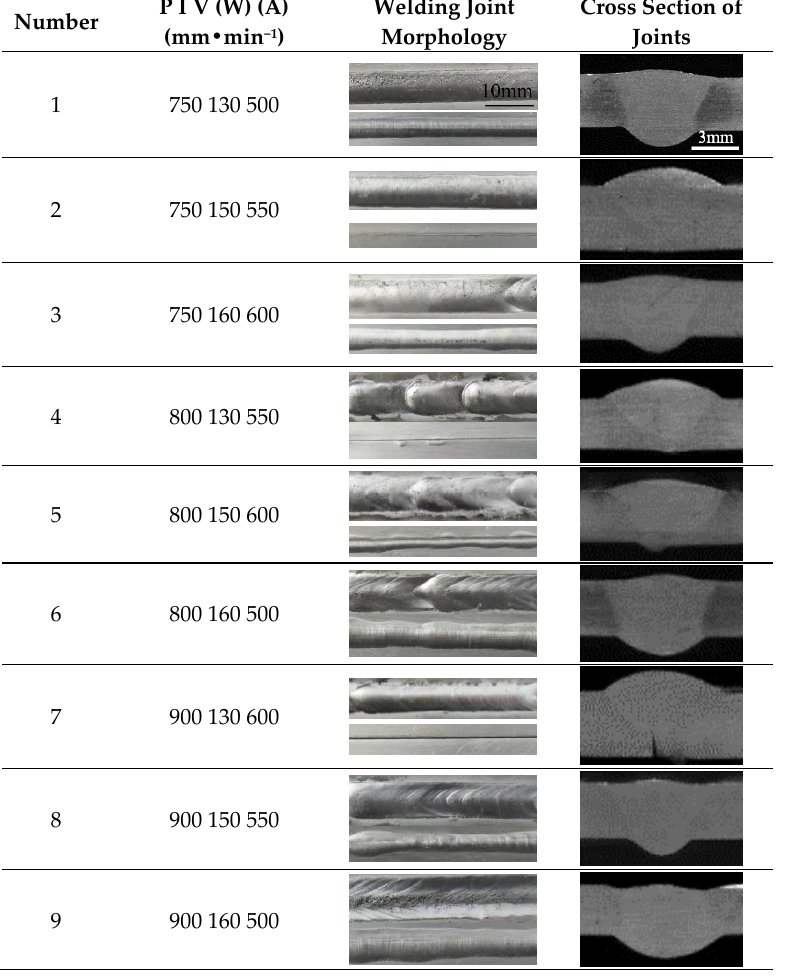
Figure 3. Morphology and cross section of welding joints in di ff erent